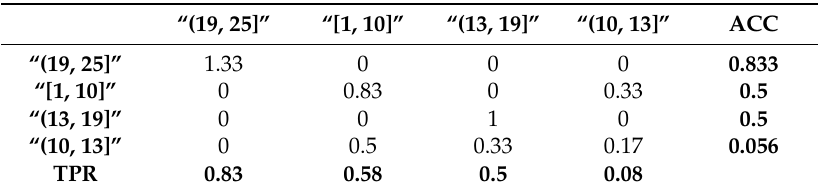
Table 13. Confusion matrix for UPDRS II classifier. Accuracy 78.6%, coverage 75.7%. 40 examination records classified with decomposition tree and six-fold cross validation method.